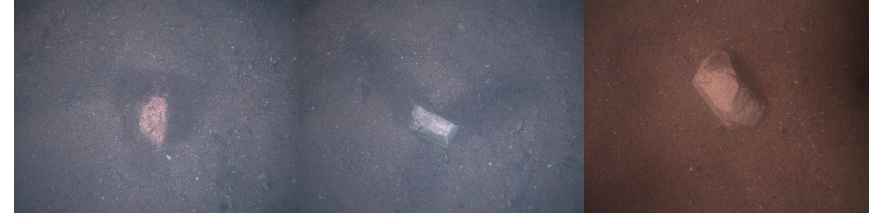
Figure 6. Example of MUED.